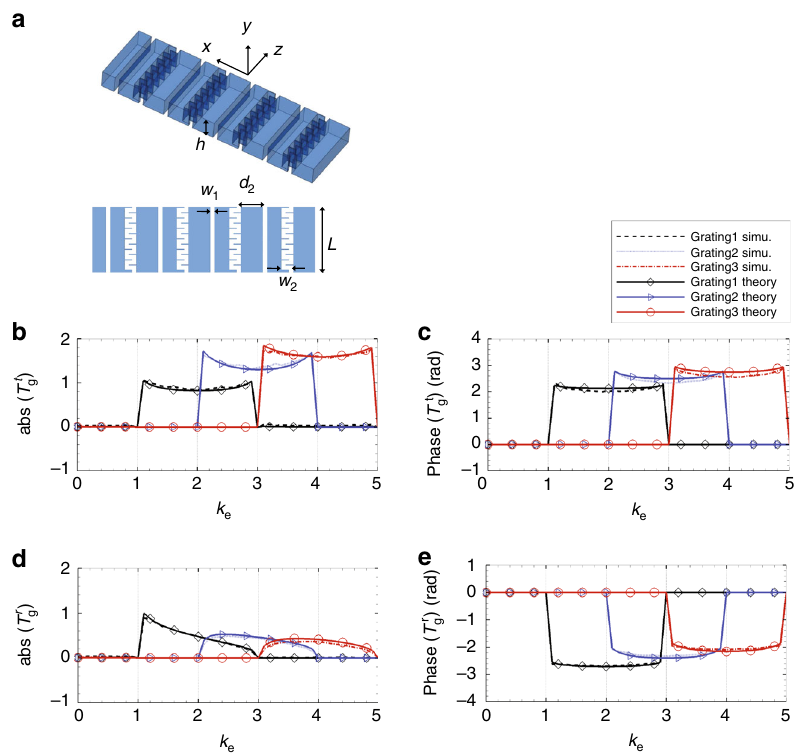
Fig. 3 Model and properties of the grating layer. a Model for grating layer. Geometrical parameters are: w 1 = 1.25 mm, w 2 = 6.95 mm, L = 18.75 mm. Changing the grating period d 2 will results in different k G . We choose d 2 = 18.9 mm for k G = 2 k 0 (grating1), d 2 = 12.6 mm for k G = 3 k 0 (grating2), and d = 9.4 mm for k = 4 k 2 G 0 (grating3). b , c Amplitudes ( b ) and phases ( c ) of theoretical and simulated transmission coef transmitter. d , e Amplitudes ( d ) and phases ( e ) of theoretical and simulated transmission coef fi cients of grating layers in the